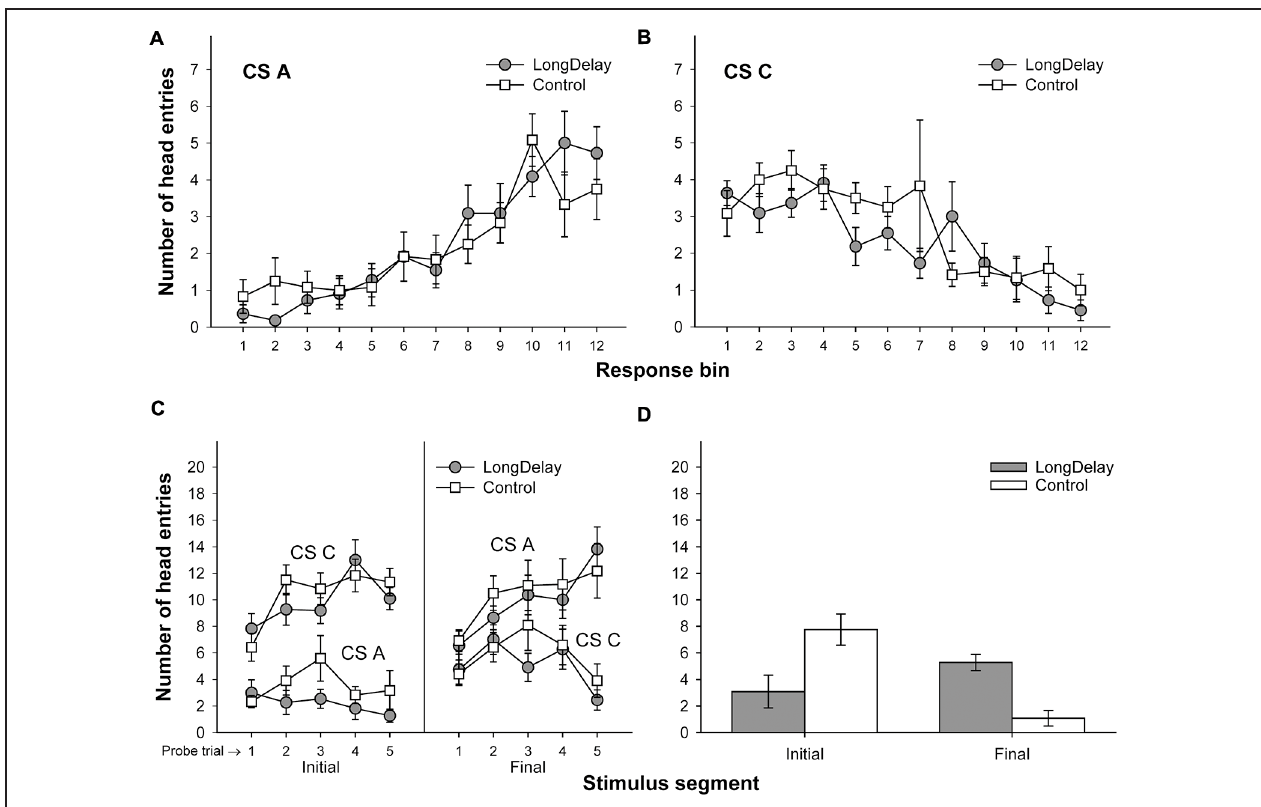
FIGURE 3 | Results of Experiment 1a. The top panels represent responding to CSs A (A) and C (B) during each of the 12 5-s bins of the last probe trial of long delay conditioning training. US delivery was expected at 55 s (Bin 11) or 10 s (Bin 2) after onset of CSs A and C, respectively. (C) Presents responding to the initial (average of Bins 1–3) and final (average of Bins 10–12) segments of CSs A and C during the five probe trials of long delay conditioning training. (D) Presents responding to the initial and final segments of CSs A (Group LongDelay) and B (Group Control) during the probe trial of retardation training. Brackets represent the standard error of the